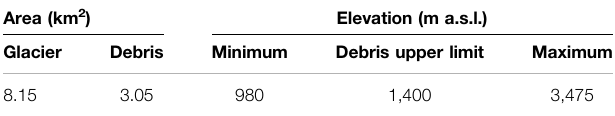
TABLE 1 | Characteristics of Verde glacier, including the area of the whole glacier and the debris cover. Area (km 2 ) Elevation (m